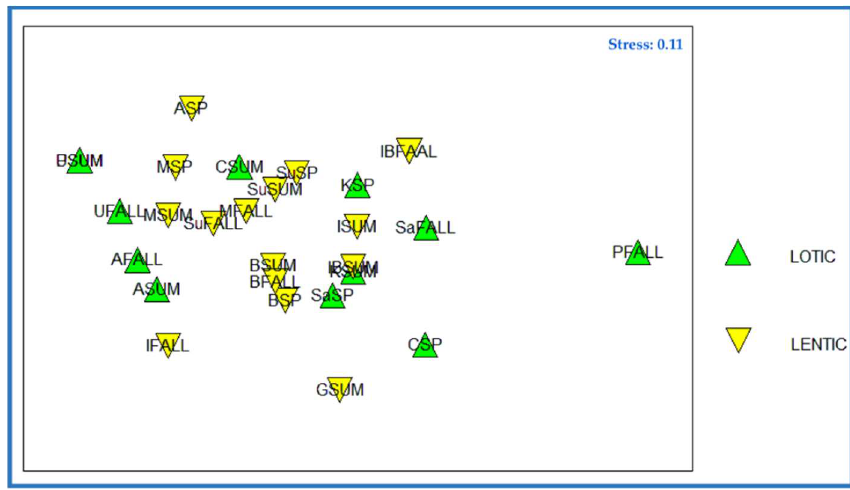
Figure 4. nMDS results of lotic and lentic sites (green triangles: lotic sites-A: Aksaray; C: Çeltik; U: